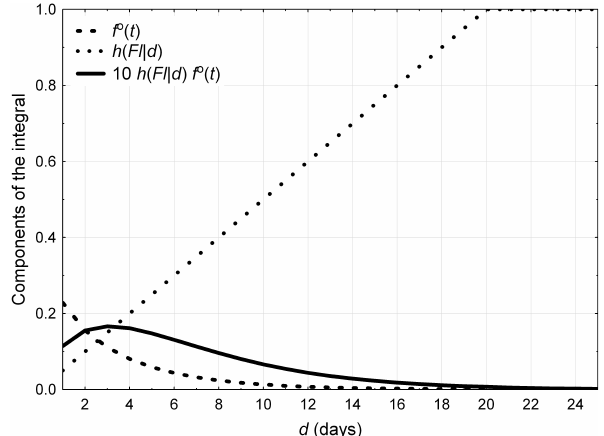
Fig. 6. Components of the integral Eq.